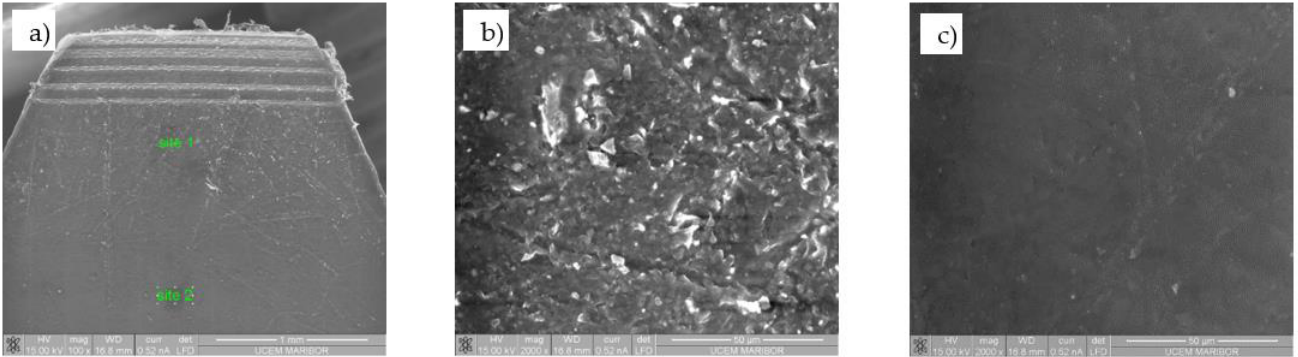
Figure 4. SEM micrograph of the POM-gear without coating ( a ), SEM micrograph at site 1 ( b ), SEM LFD micrograph at site 2 ( c ).